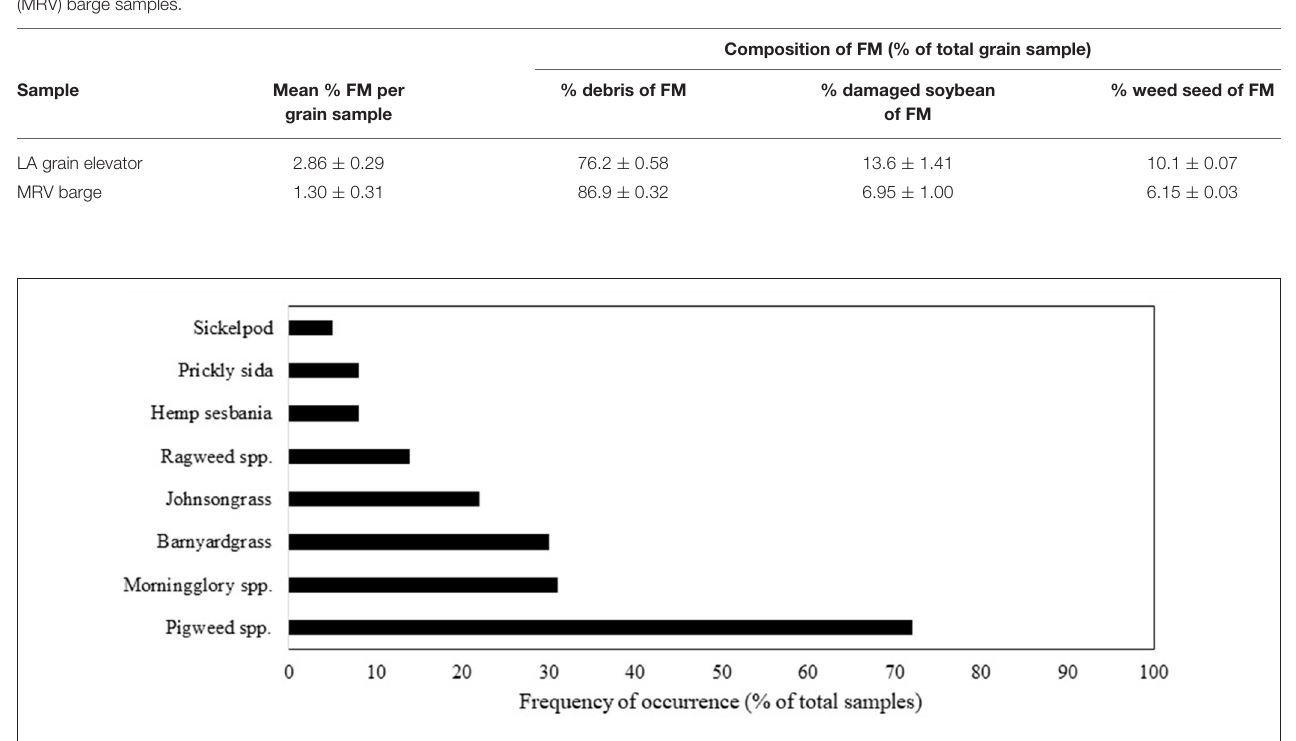
FIGURE 2 | Frequency of occurrence (% of the total grain samples) of common weed species.